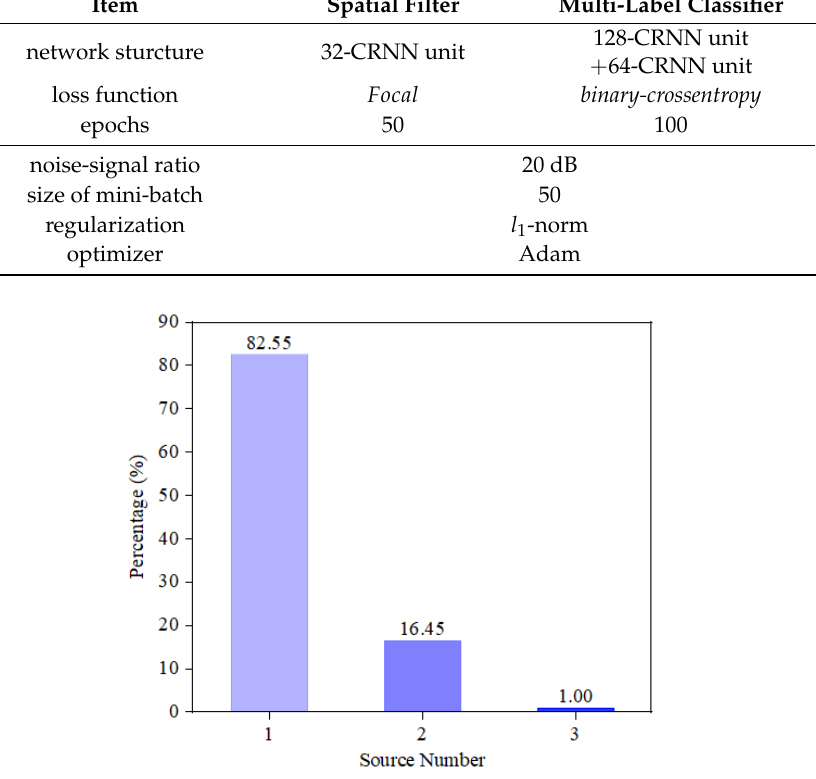
Figure 6. Source number distribution of the same